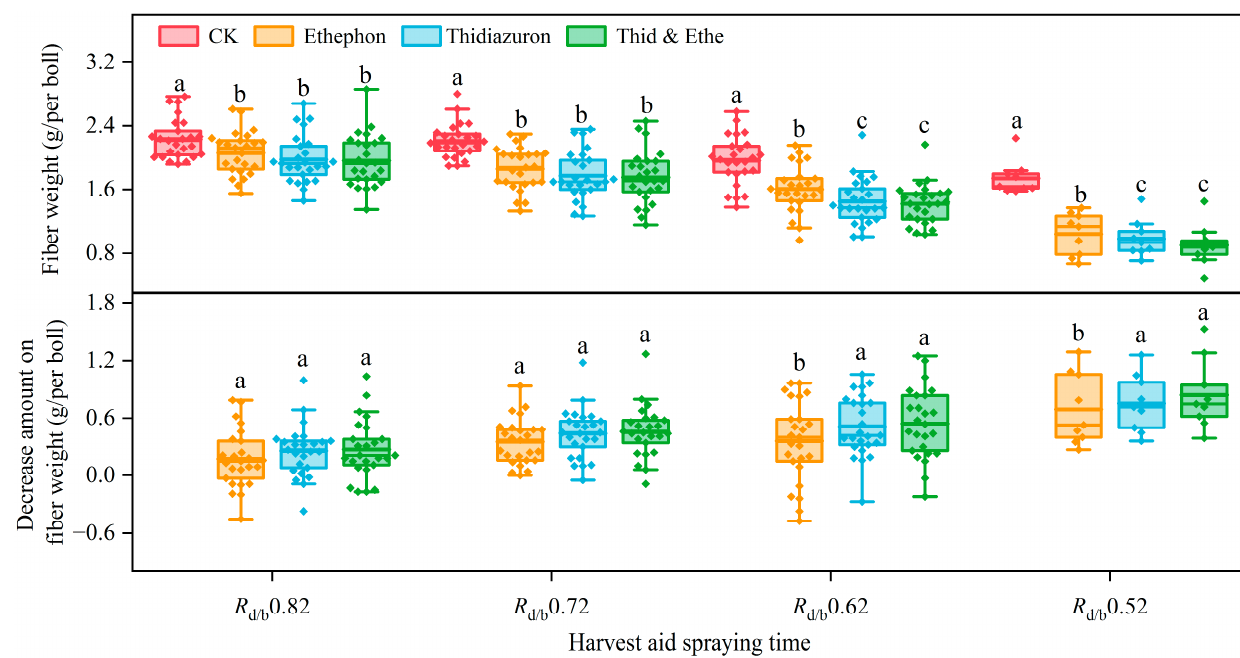
Figure 3. Effects of harvest aid spraying time on fiber weight per boll. The thick solid line in the figure